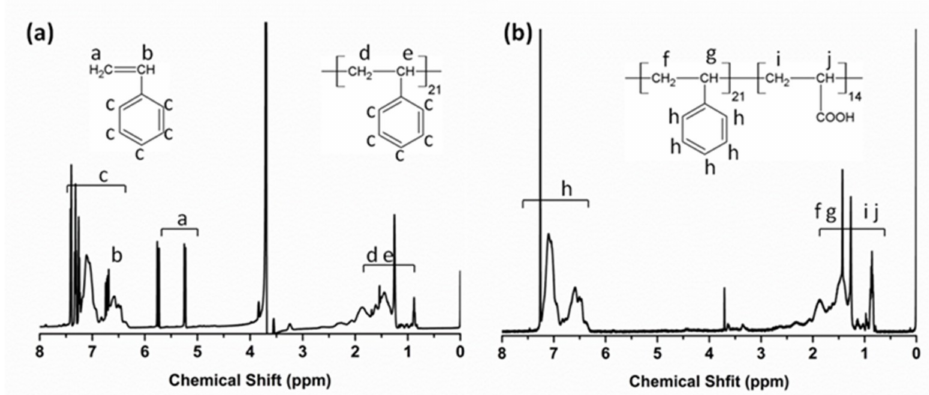
Figure 2. 1 H NMR spectra of PS reaction mixture after polymerization ( a ) and PS 21 -b-PAA 14 ( b